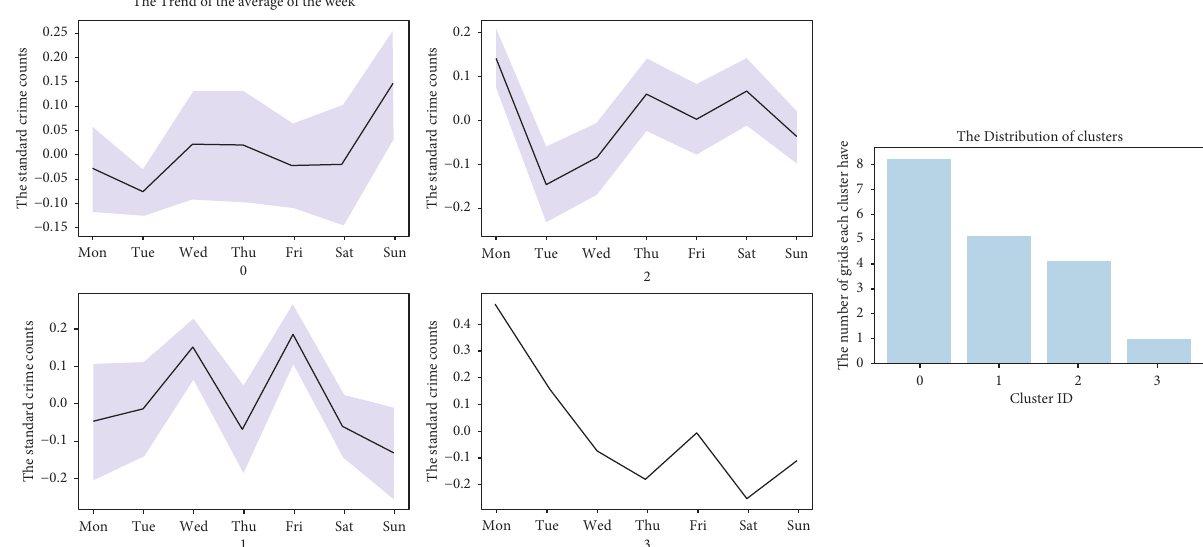
Figure 13: The theft in Santa Monica trends in the average weeks in 2018 and the distribution of clusters. The line charts are the weekly trends of theft in Santa Monica in 2018. The bar chart is the distribution of the clusters.